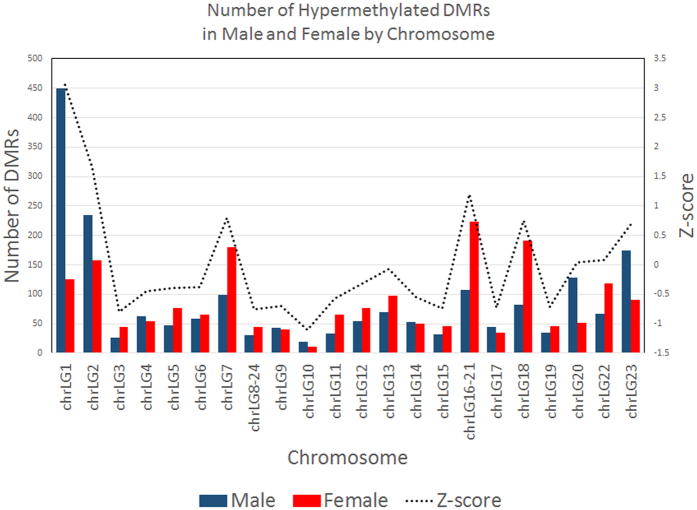
Distribution of CpG methylation level across various genomic elements such as promoters, introns, exons, DNA transposons, SINEs, LINEs and LTRs in male and female tilapia.The percentage of repeat elements is summarized according to chromosome locations.